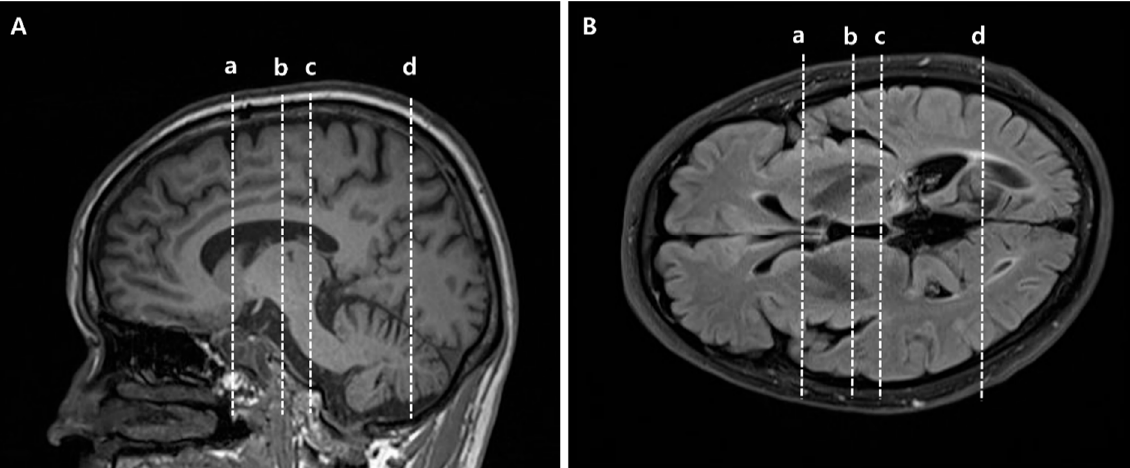
Figure 1. Specific anatomical locations of seed and target ROIs of ATR and PTR in slice levels in brain MR images. (a) Target ROI of ATR where the frontal and temporal lobes are separated. Equivalent slice level to (a) in Supplementary Materials Figure S3. (b) Seed ROI of ATR located on the anterior part of the thalamus where the substantia nigra first appears. Equivalent slice level to (b) in Supplementary Materials Figure S3. (c) Seed ROI of PTR located on the posterior part of the thalamus, where the posterior tip of the putamen lies. Equivalent slice level to (c) in Supplementary Materials Figure S4. (d) Target ROI of PTR located below the parieto-occipital sulcus. Equivalent slice level to (d) in Supplementary Materials Figure S4.